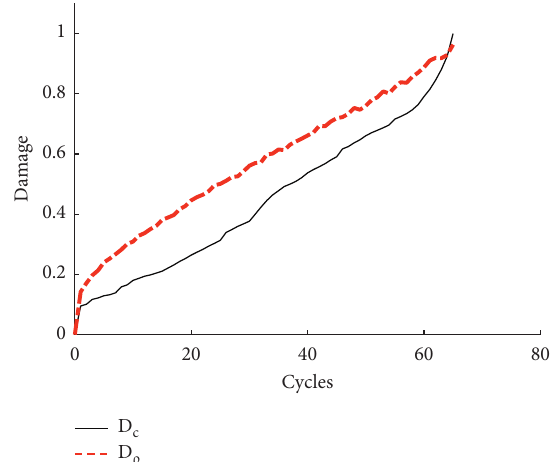
Figure 9: Rock’s damage variables based on resistivity and AE.